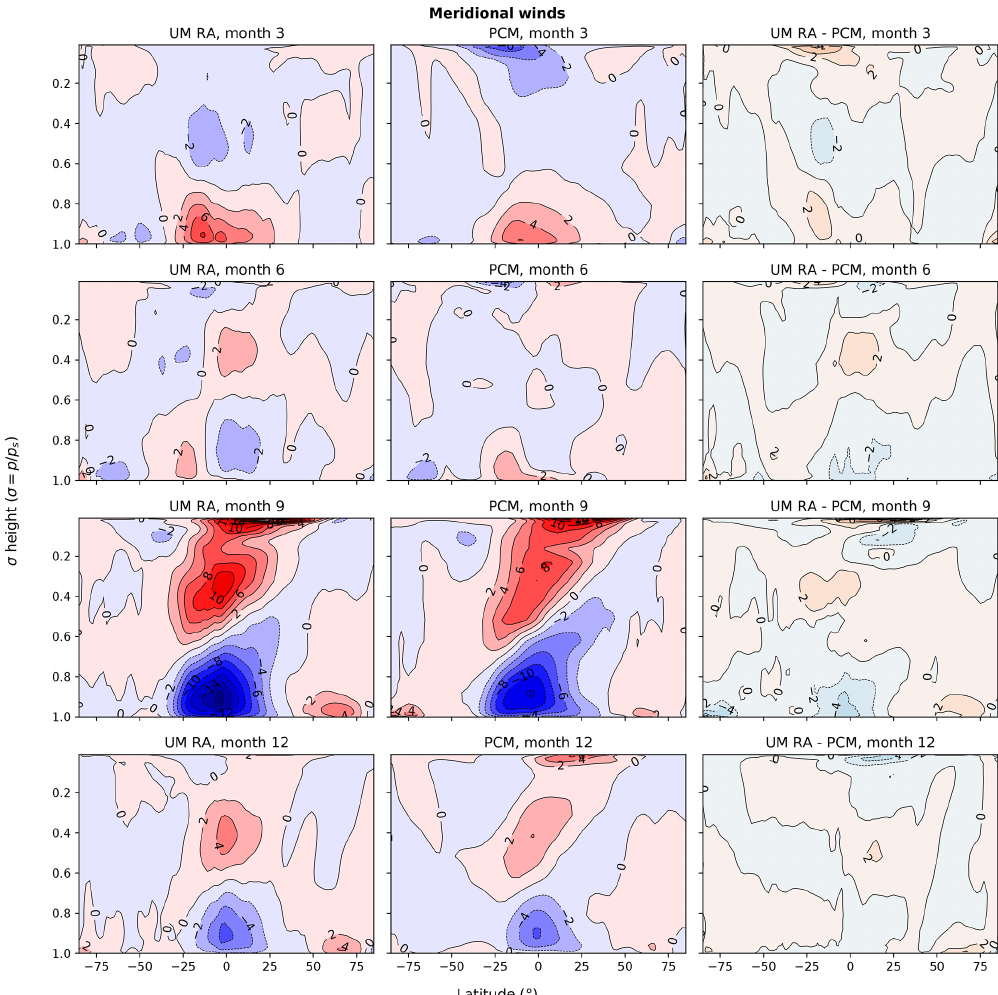
Figure A7. Zonal mean meridional winds (ms − 1 ) across four seasons within the Martian year. For each month, the time average is taken of all sols within that month. The RA dust scenario is shown on the left, the PCM output in the centre and the differences between models on the right. Colour scales in the left-hand and right-hand plots are matched across all months and between models, with contour intervals of 2ms − 1 . The contours in the difference plots are not matched due to the varying intensity of the difference between months. Positive values indicate an eastward wind and negative values a westward